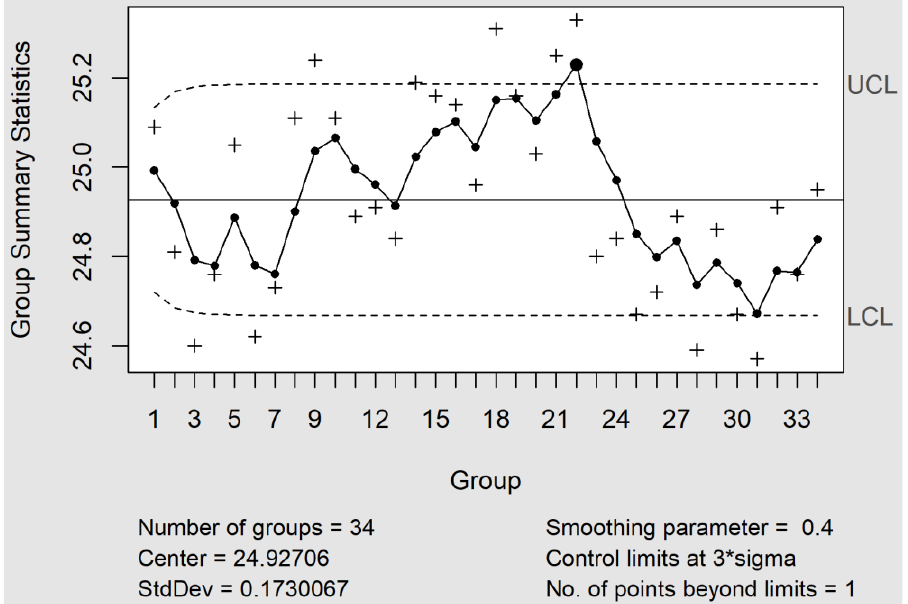
Figure 3. The EWMA control chart with the parameters λ = 0.4 and L = 3.054. Under these conditions, the sample #22 (in red) was outside the control limits, whereas the number of points beyond the limits was three for λ = 0.2. The causes were attributable to a column change. UCL and LCL are the upper and lower control limits.